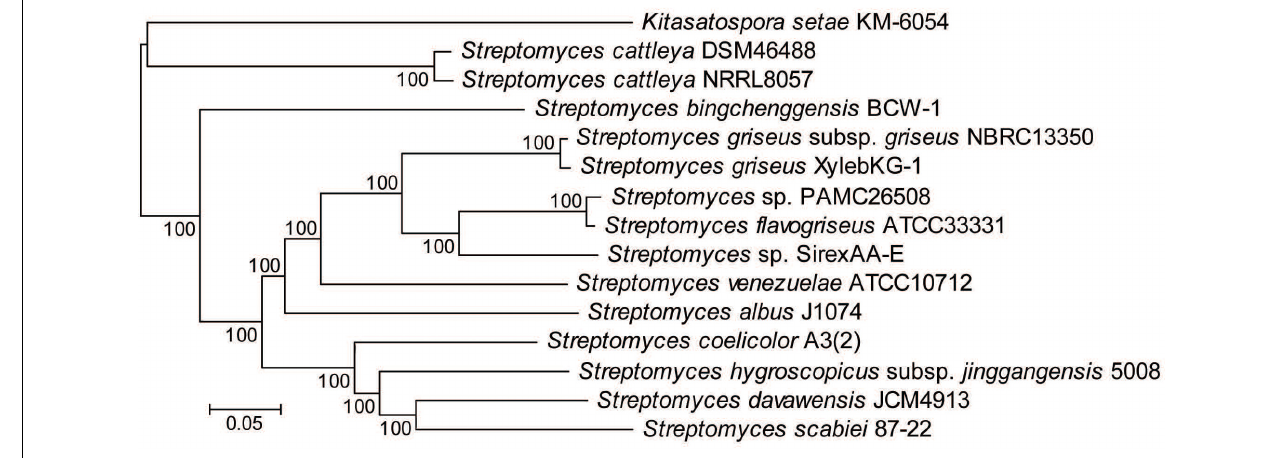
FIGURE 3 | Multilocus phylogeny constructed from 1,364 gene families conserved in all Streptomyces genomes analyzed. Alignments were done using MAFFT and the phylogeny generated using RAxML. Numbers above the branches based on 100 rapid bootstraps and the scale bar indicates the number of substitutions per site.